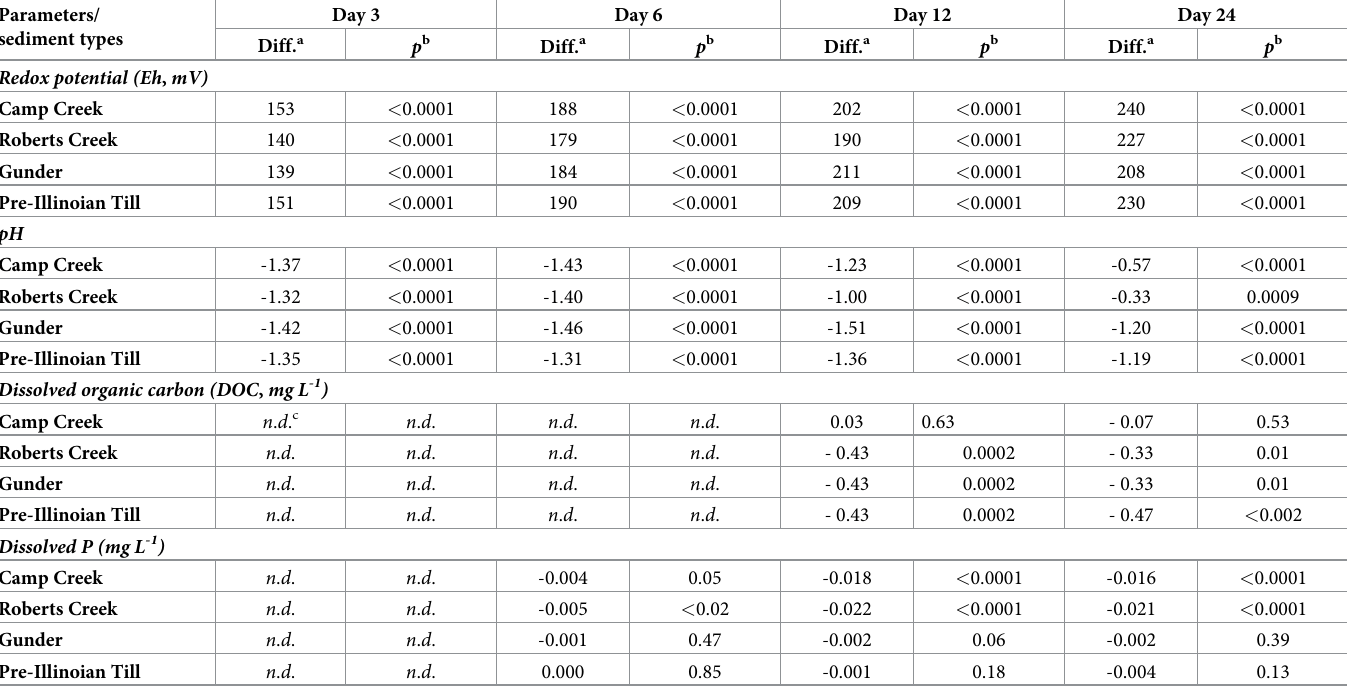
Table 3. Differences between aerobic conditions (with air purging) and anaerobic conditions (with nitrogen purging) in redox potential (Eh), pH, dissolved organic carbon (DOC), and dissolved P in the solution for each sediment during 24 days of incubation. DOC and P concentrations are in mg L -1 , and Eh is in mV. Compare with Fig